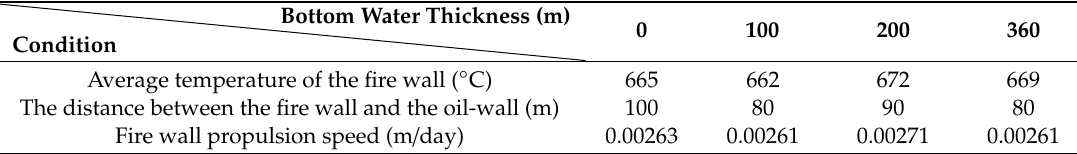
Table 13. Characteristic parameters of the fire wall under di ff erent bottom water thickness.